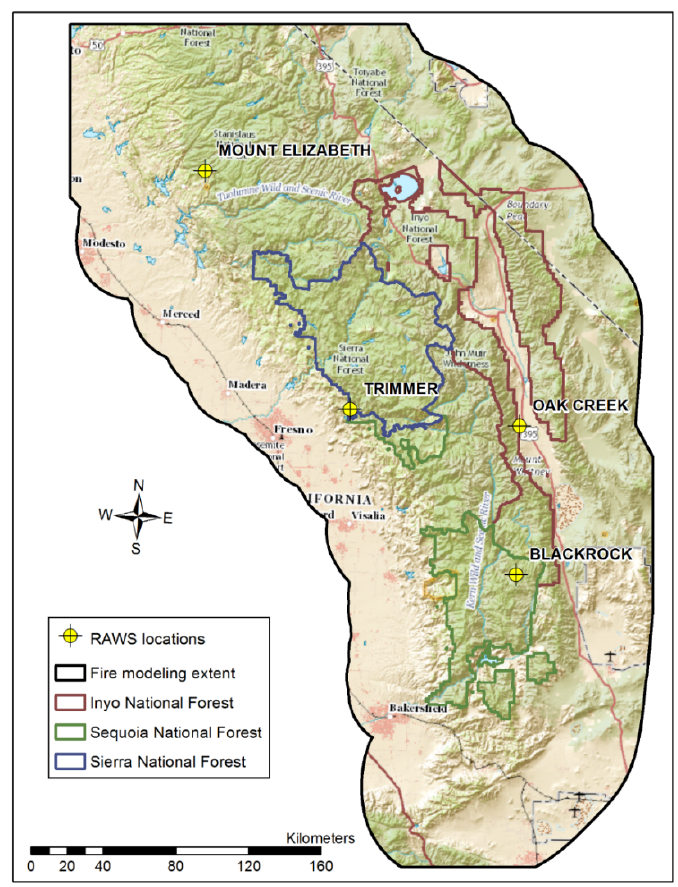
Figure 4. Map of Remote Automated Weather Station (RAWS) locations used in the Southern Sierra Risk Assessment.